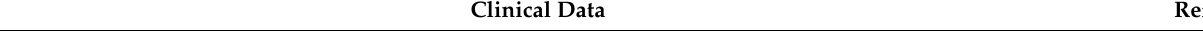
Table 2. Cont. Clinical